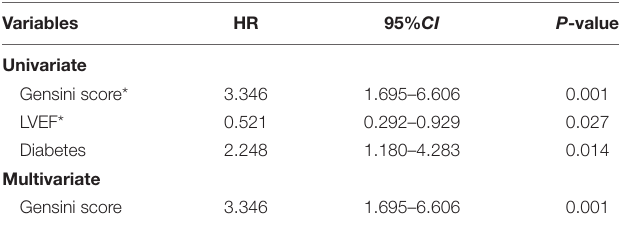
TABLE 5 | A multivariate Cox regression model evaluating the association of clinical factors with MACE during follow-up in our validated cohort. Variables HR 95% CI P